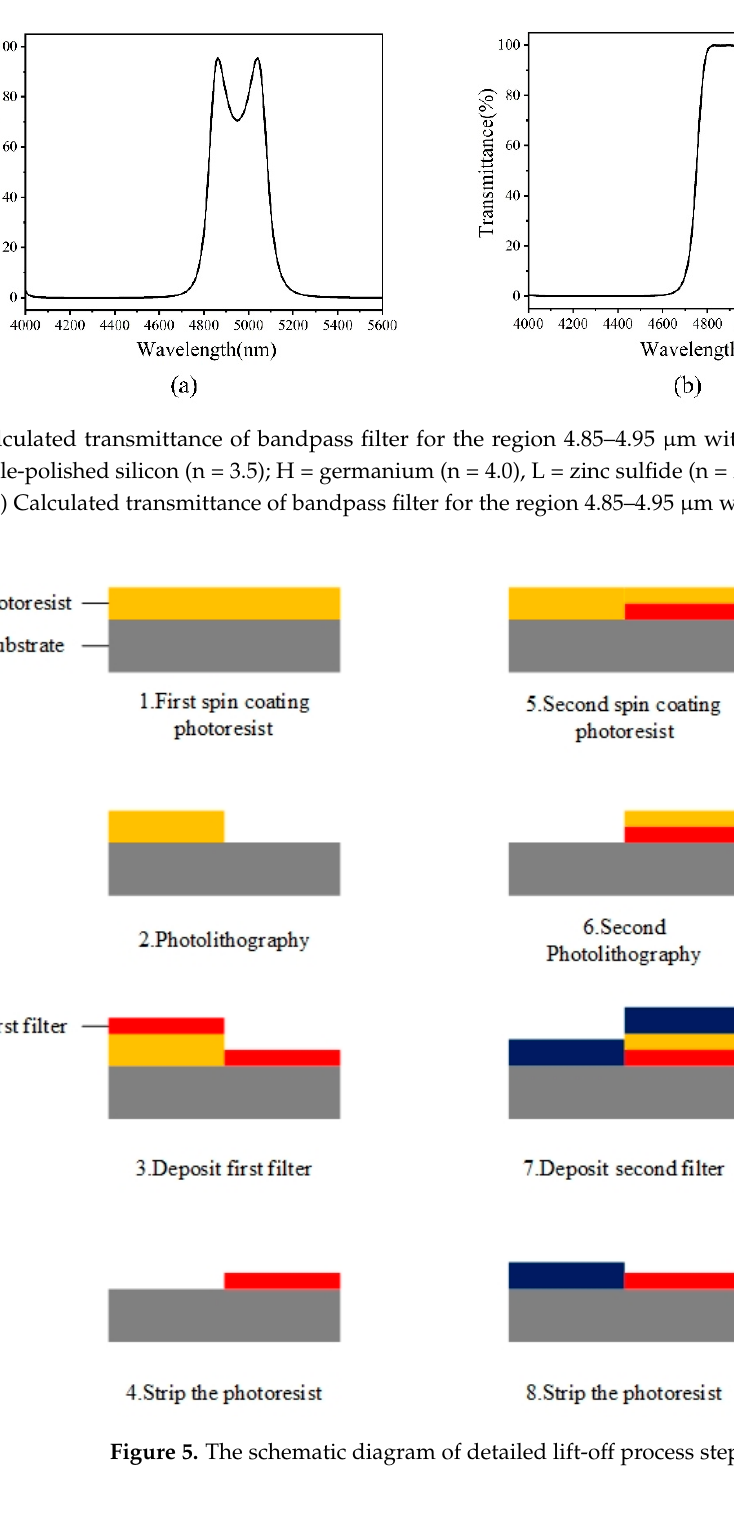
Figure 4. ( a ) Calculated transmittance of bandpass filter for the region 4.85–4.95 µm with the pri- mary structure. The substrate is double-polished silicon (n = 3.5); H = germanium (n = 4.0), L = zinc sulfide (n = 2.35) and the incident medium is air (n = 1.0). ( b ) Calculated transmittance of bandpass filter for the region 4.85–4.95 µm with the optimized structure.